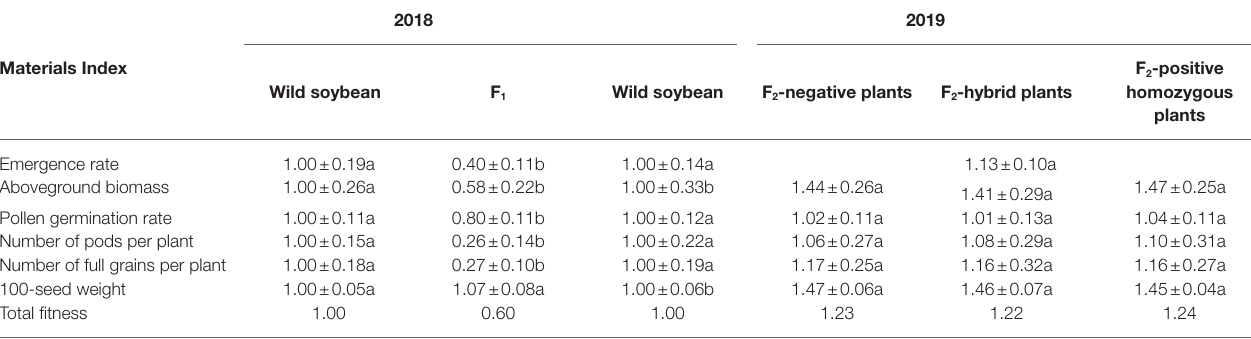
TABLE 7 | Changes in fitness of vegetative reproductive indices of hybrid F 1 and F 2 generation compared to wild